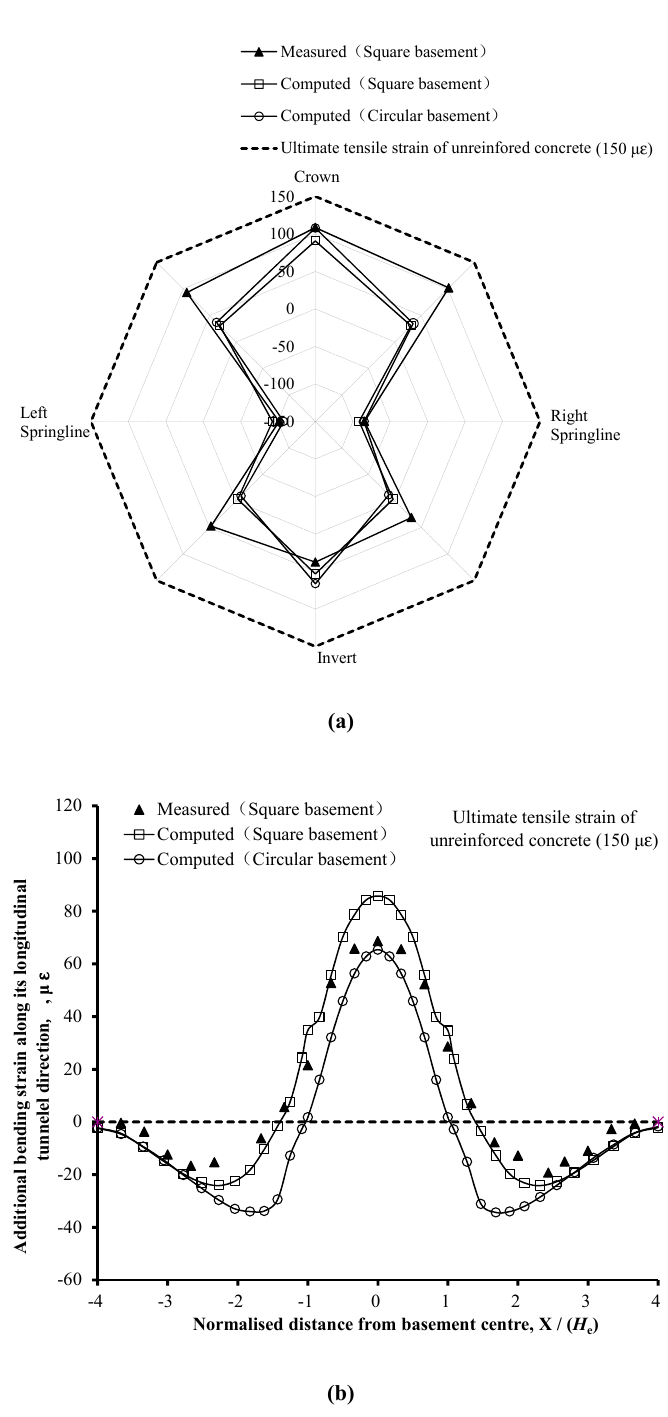
Figure 8. Additional bending strains in tunnel lining along the ( a ) transverse and ( b ) longitudinal direction.